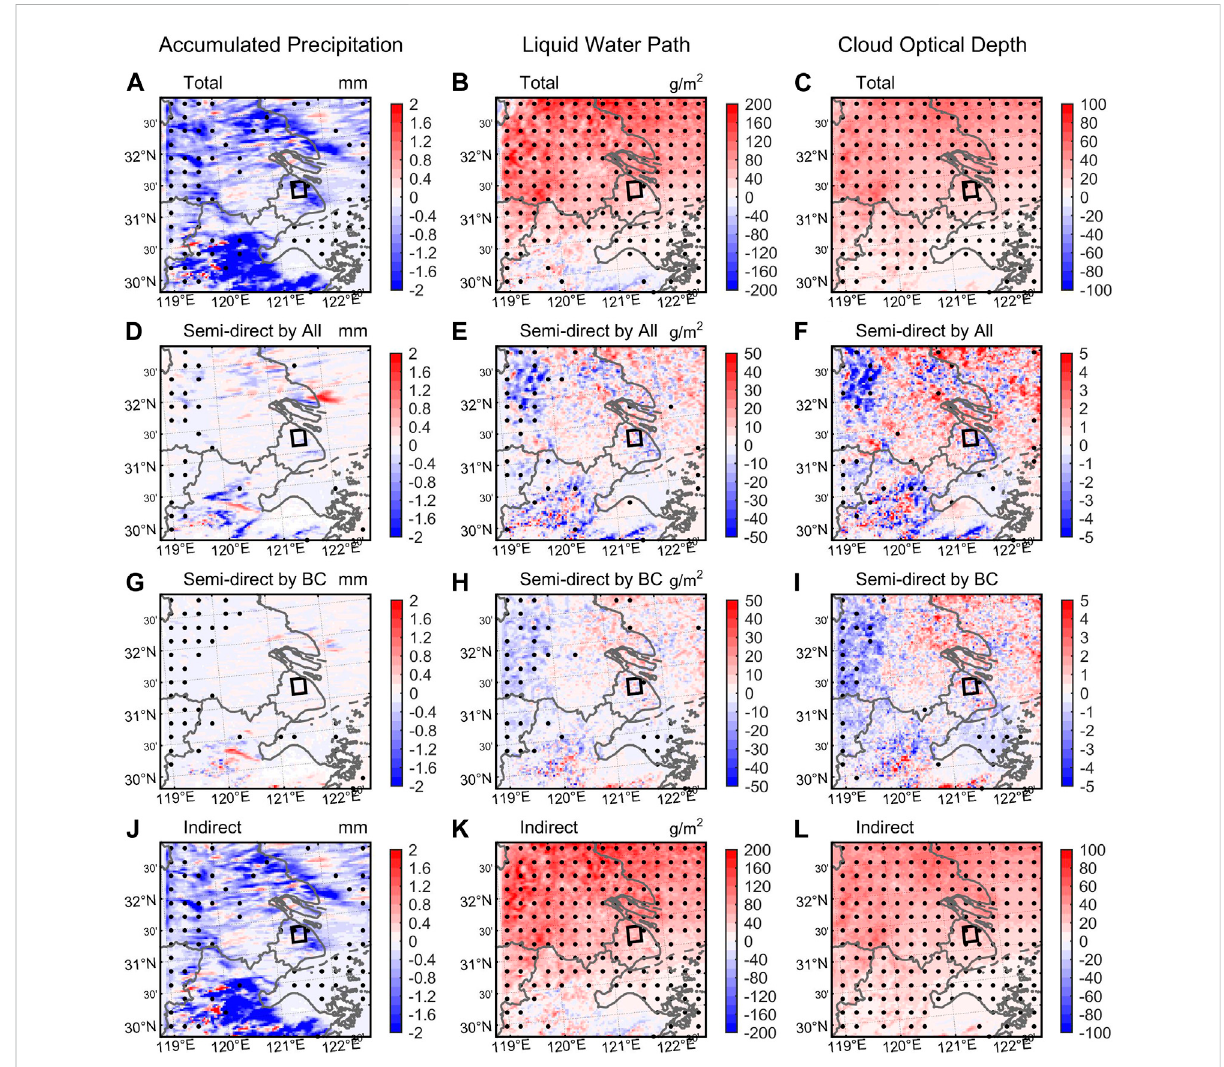
FIGURE 10 Spatial distribution of ensemble mean aerosol effect on accumulated precipitation (left column), liquid water path, (middle column), cloud optical depth (right column) intheShanghai Case, averaged from7:00 to 17:00LT. (A – C) Thetotal effect. (D – F) Thesemi-directeffect byall aerosol species. (G – I) Thesemi-directeffectbyBConly. (J – L) Theindirecteffect.Stiltedgridsindicatesigni fi cantdifferencesatthe5%signi fi cancelevel.The box regions in the city center are used for calculating mean values in the horizontal